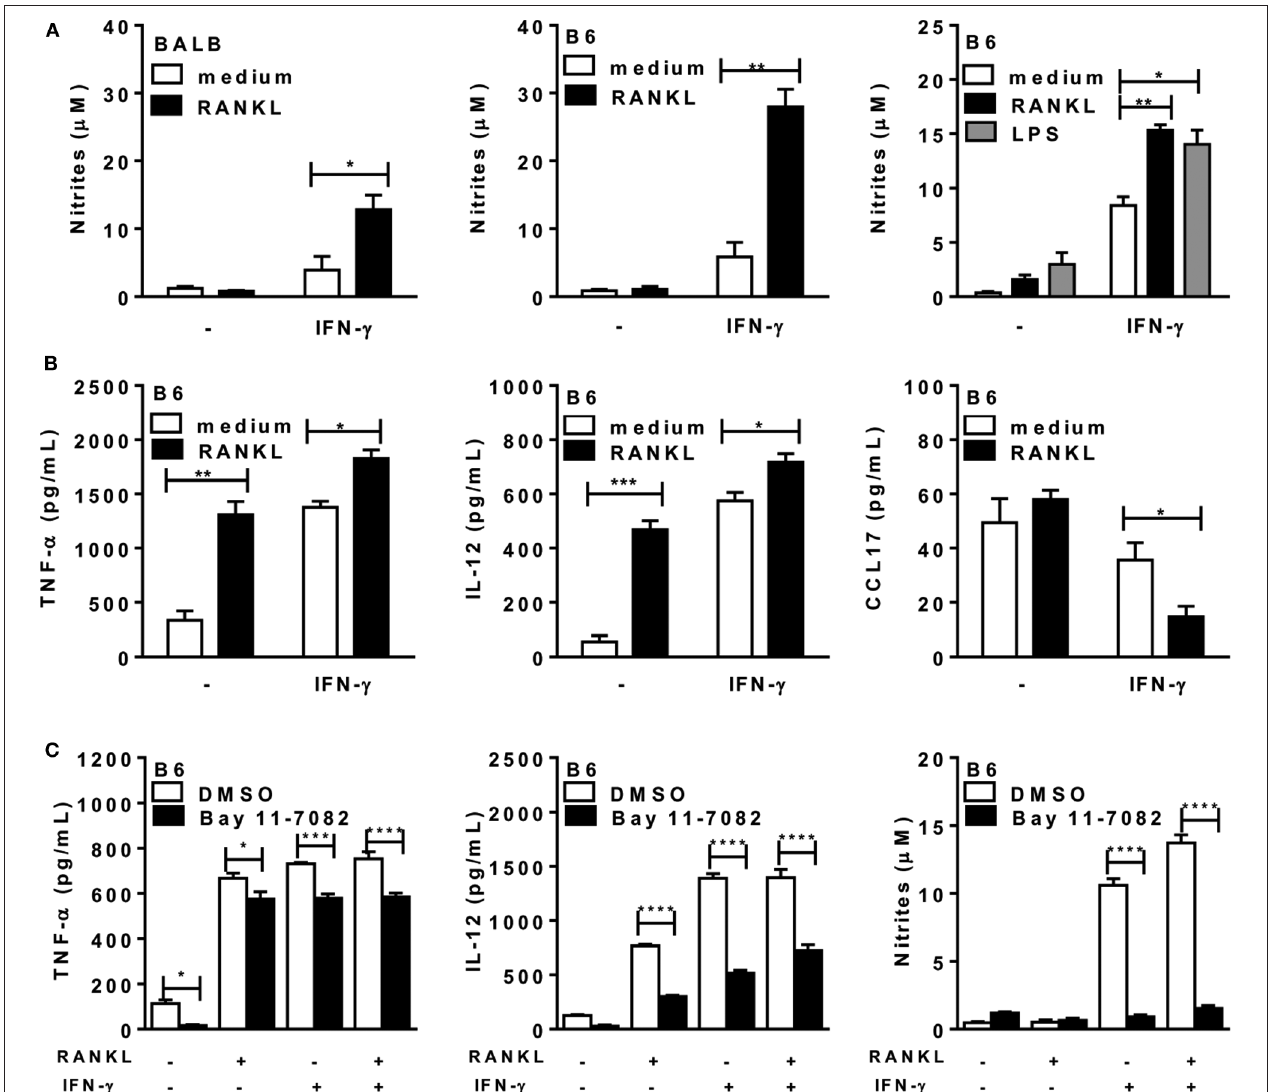
FIGURE 2 | RANKL and IFN- γ increase cytokine and NO production by macrophages. Inflammatory macrophages from B6 or BALB/c mice were cultured in triplicates with medium or RANKL in the presence or absence of IFN- γ during 48h. Some cultures also received the IKK-signaling inhibitor Bay 11-7082 or control diluent (DMSO). (A,C) Culture supernatants were tested for NO production by the Griess method. (B,C) Culture supernatants were assayed for TNF- α , IL-12p70, and CCL17 by ELISA. Results are expressed as means and S.E.M. For (A,B) , significant differences between macrophages treated with or without RANKL were analyzed by t -test. Data are representative of 3 independent experiments. In ( A , right panel) LPS (200ng/mL) was used as a positive control and the results were analyzed by one-way ANOVA, followed by Tukey post-test. In (C) , data were analyzed by one-way ANOVA, followed by Bonferroni post-test. Significant differences were indicated for * P < 0.05, ** P < 0.01, *** P < 0.001, and **** P <